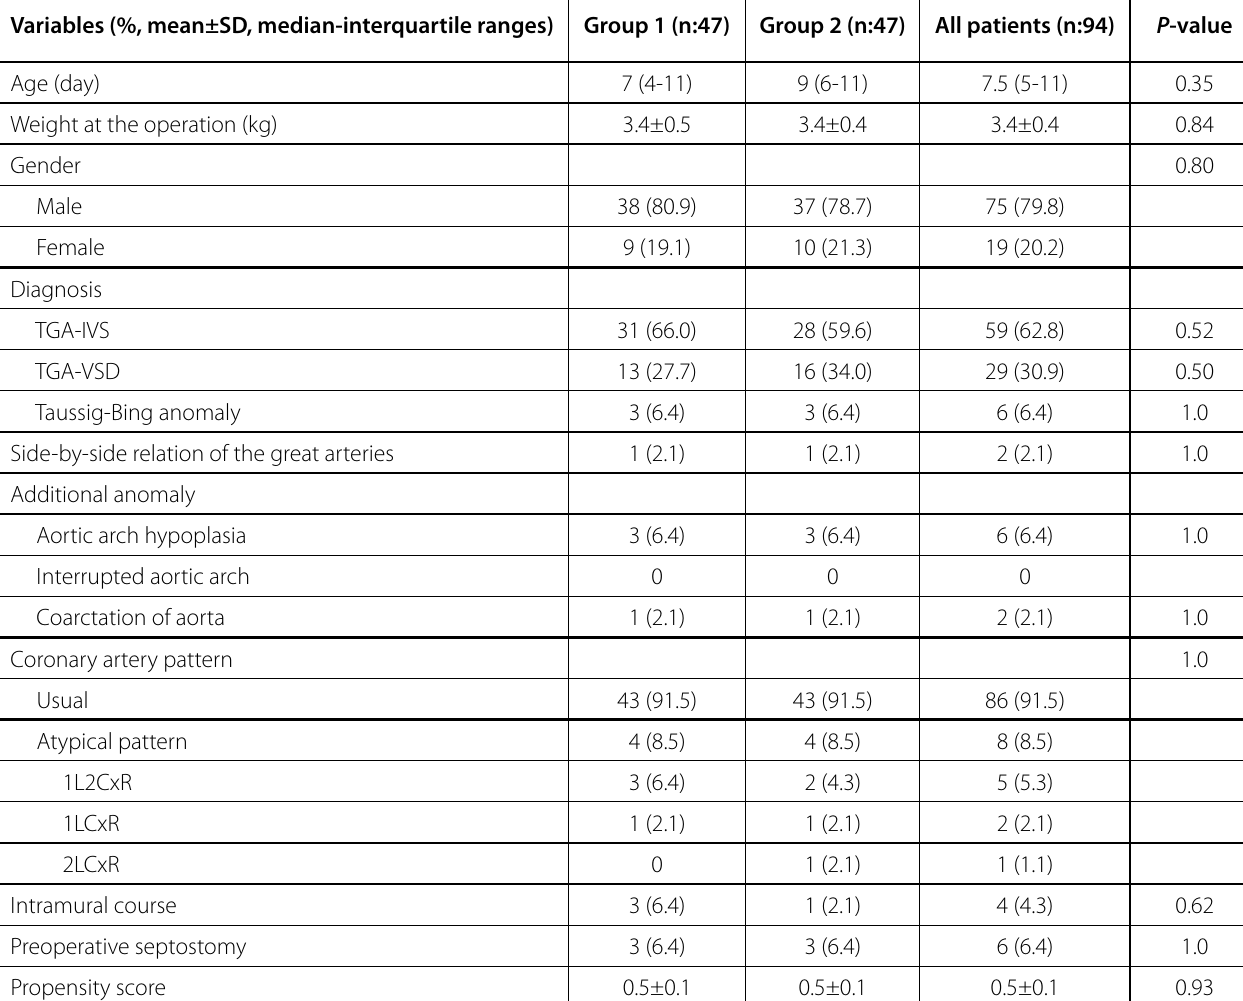
Table 2 . Preoperative patients’ characteristics after the propensity score matching. Variables (%, mean±SD, median-interquartile